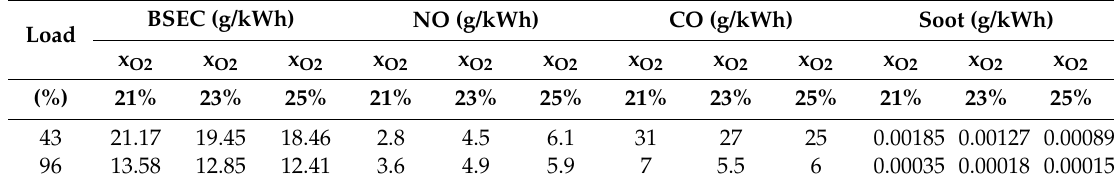
Table 4. Experimental data for NG/DDF engine operating mode, with “normal pilot fuel” quantity, at